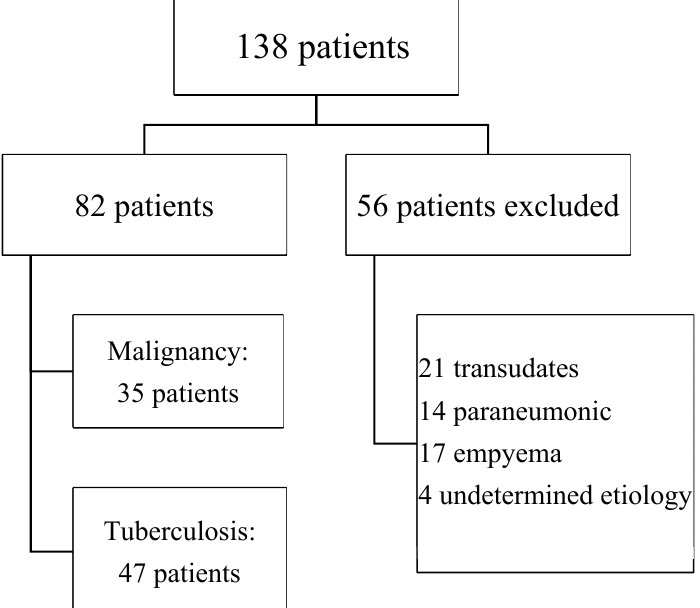
Figure 1. Flowchart of patient inclusion.